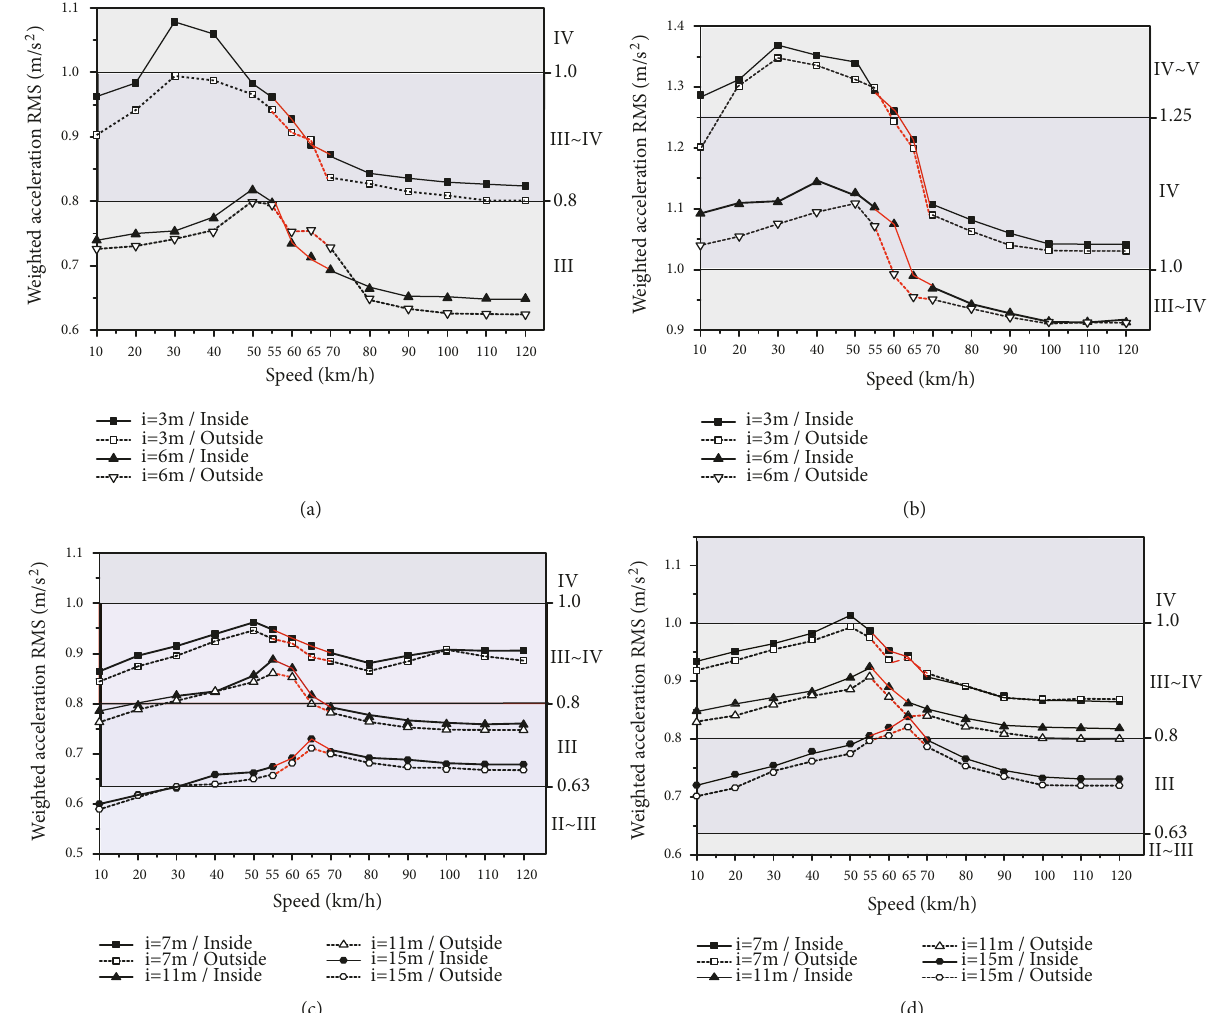
Figure 6: The combined total weighted accelerationRMS for the deceleration lane between 10km/h and 120 km/h: (a) the linear deceleration lane (car); (b) the linear deceleration lane (semi-trailer truck); (c) the curved deceleration lane (car); (d) the curved deceleration lane (semi- trailer